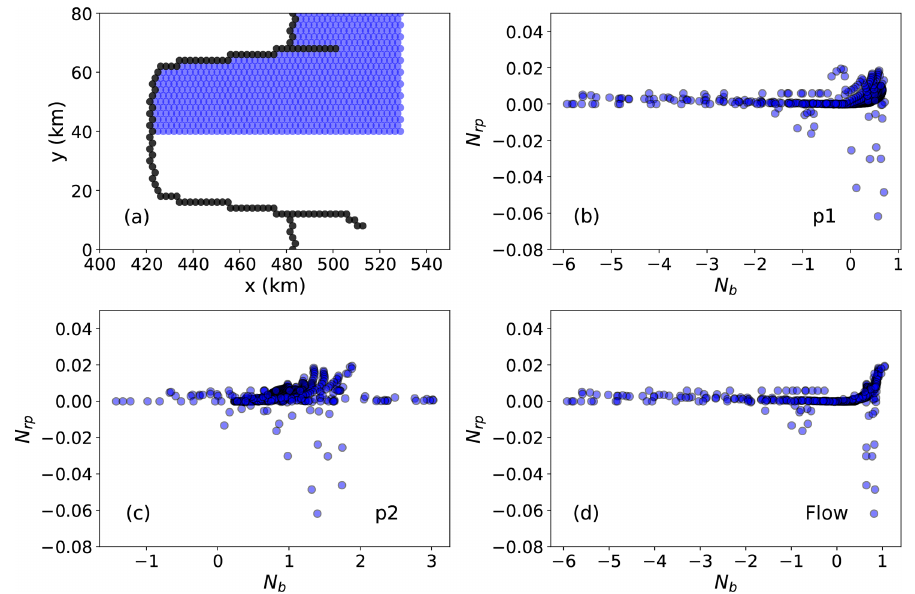
Figure 3. (a) Blue dots represent the locations of all perturbation points analyzed (730) for the N rp : N b relation analysis. Black dots indicate grid cells located along the grounding line. (b–d) Modeled N rp versus buttressing number N b calculated along (b) n p1 , (c) n p2 , and (d) n f .